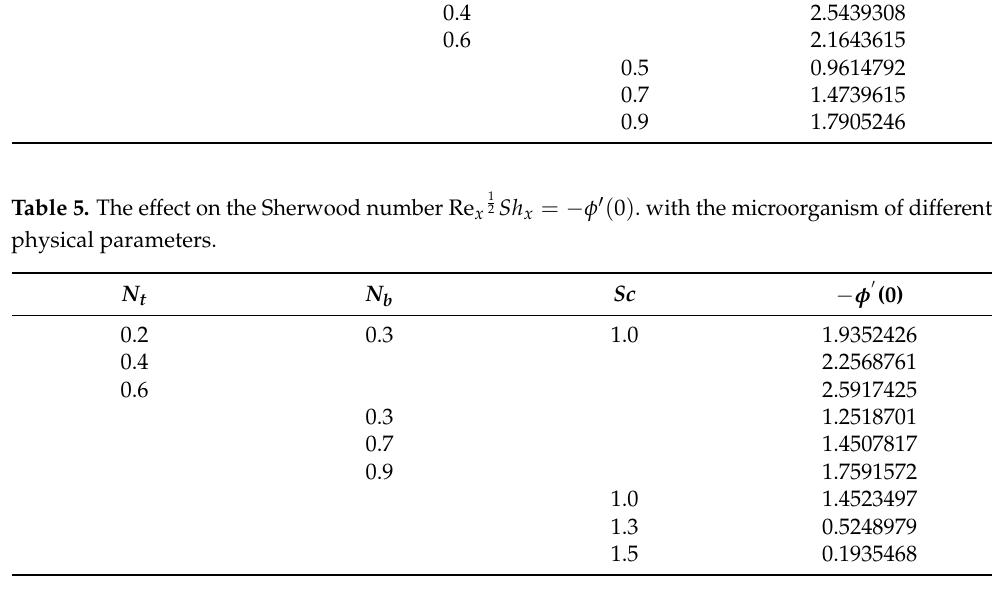
(cid:16) (cid:17) R θ (cid:48) ( 0 ) with the microorganism of different 1 + 4 3 k f